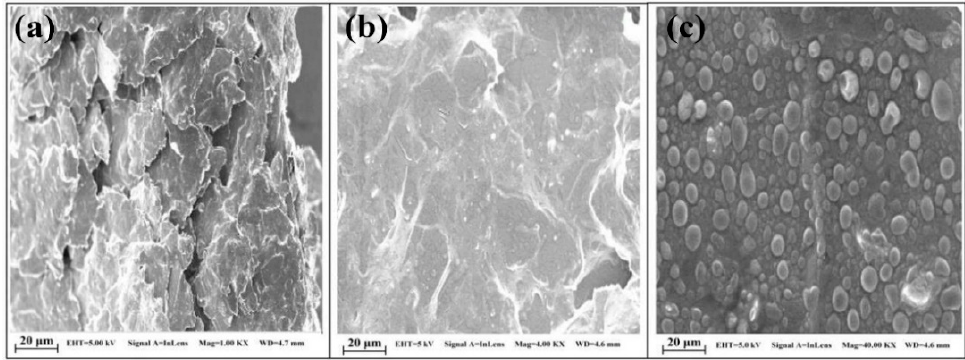
Figure 19. FE-SEM micrographs of ( a ) CPE, ( b ) PEB/CPE and ( c ) SDS/PEB/CPE. Reproduced with permission from [218]. Copyright 2019 Wiley-Blackwell Publishing Ltd.